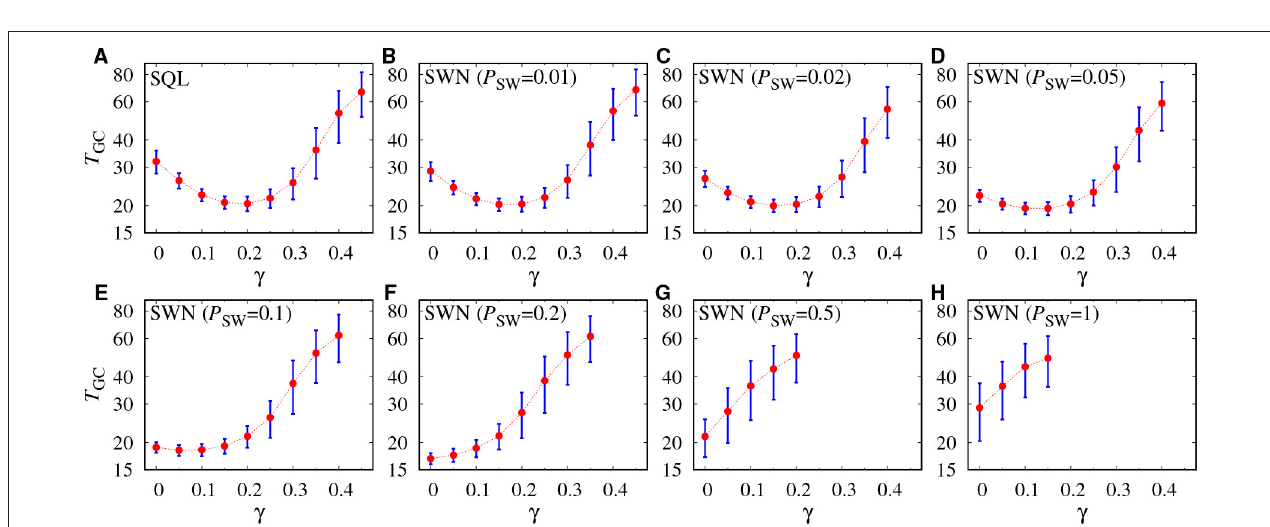
FIGURE 3 | Global adoption ratio N a ( t ) / N as a function of time for γ are plotted for each case. Solid circles and triangles represent the tipping point and global cascades, respectively.